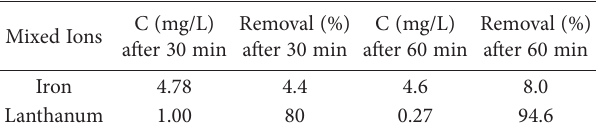
Table 4. Flotation results for a mixed solution of iron and lantha- num, using s-octanoyl-cys surfactant in a batch process. Initial con- centration of La and Fe are 5 mg/L. Initial surfactant concentration = 0.01M and pH=8. (Reproduced from 12 ).